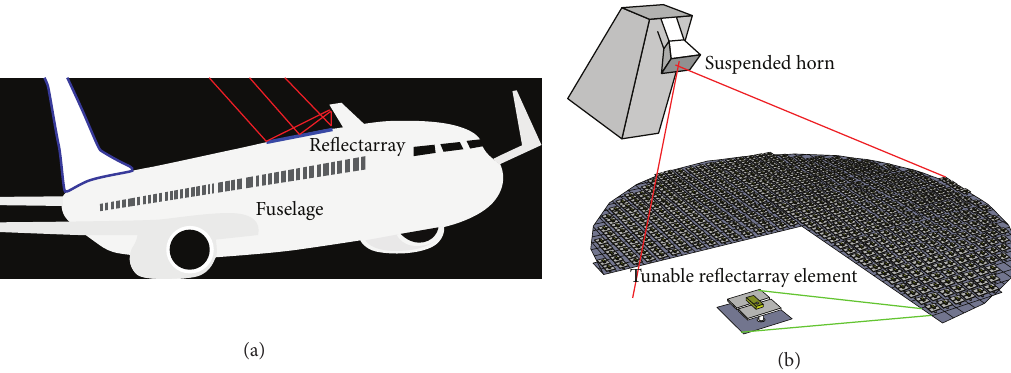
Figure 3: Arrangement of the RETINA SatCom antenna on top of an aircraft fuselage and the basic antenna architecture